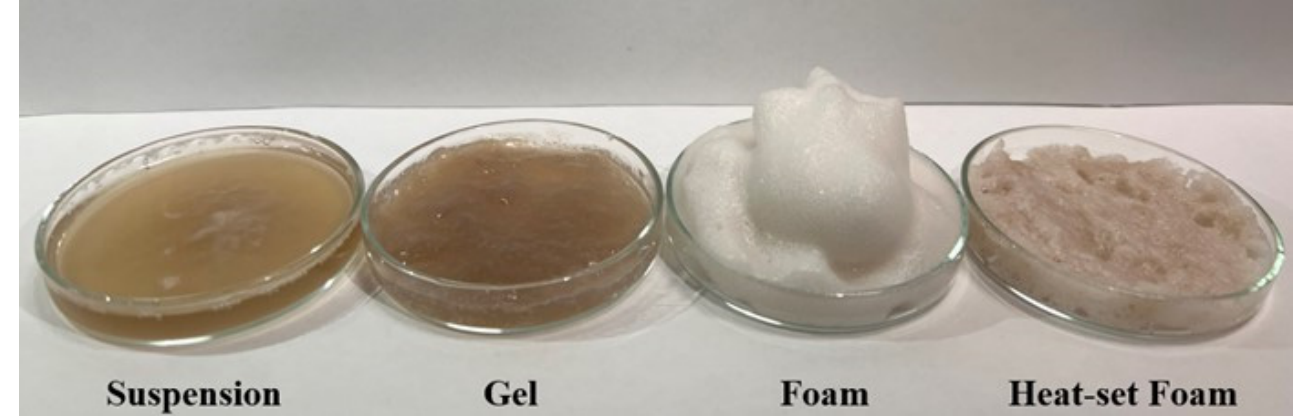
Figure 1. Visual appearance of potato protein isolate structures (4% protein, w / w